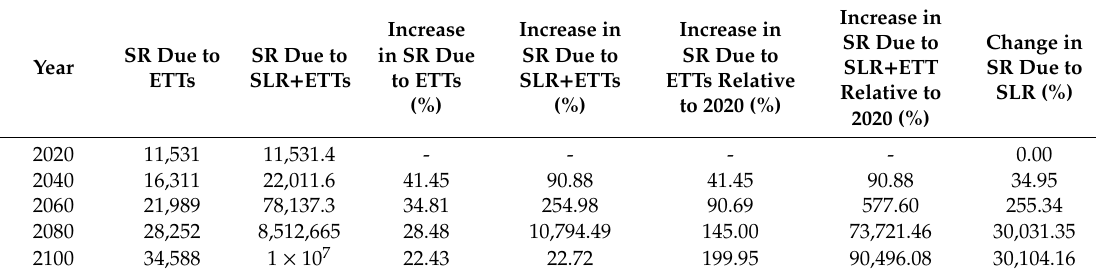
Table 10. Comparison of Social Risks (SR) at Cairo due to Earthquake Triggered Tsunami (ETTs) and Sea Level Rise